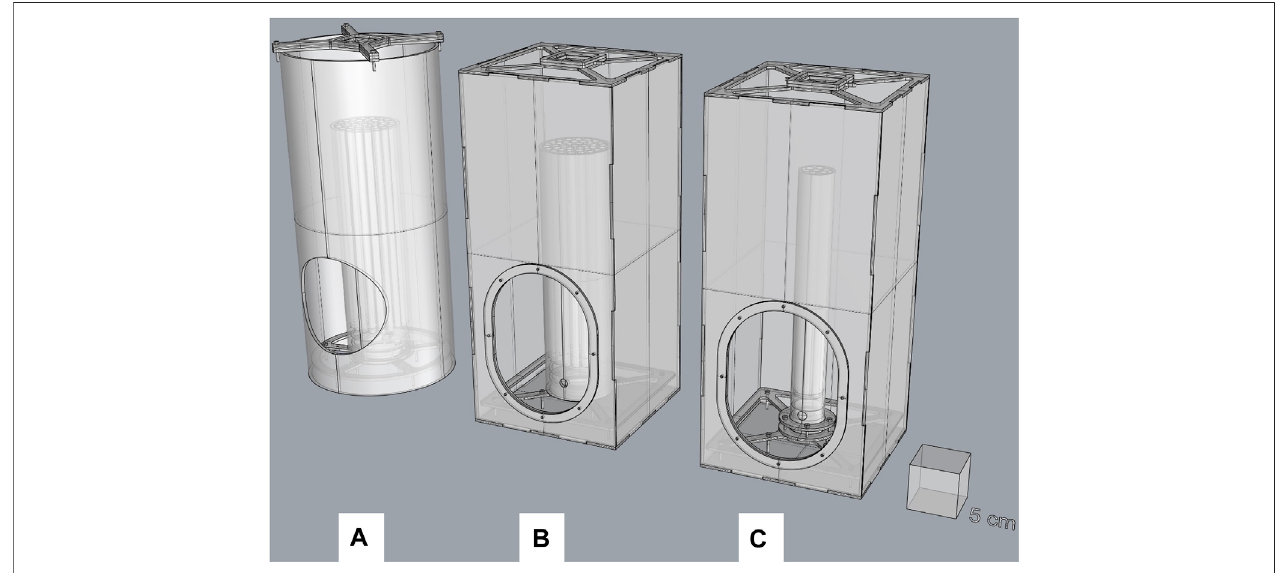
FIGURE 1 | 3D designs of the 40-tube original (version 1.0) (A) vs. the new FTDs: 40-tube FTD (version 1.1) in the middle (B) ; eight-tube FTD (version 2.0) on the right (C) .